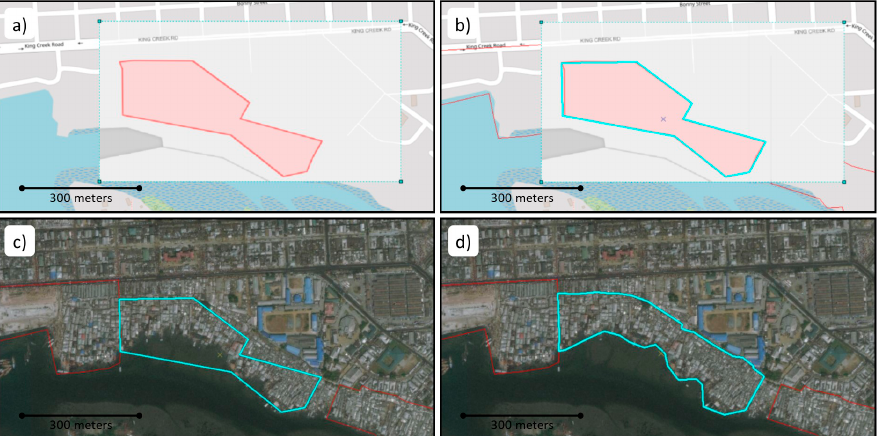
Figure A1. Process to digitize Know Your City Campaign slum settlement boundaries. Steps were